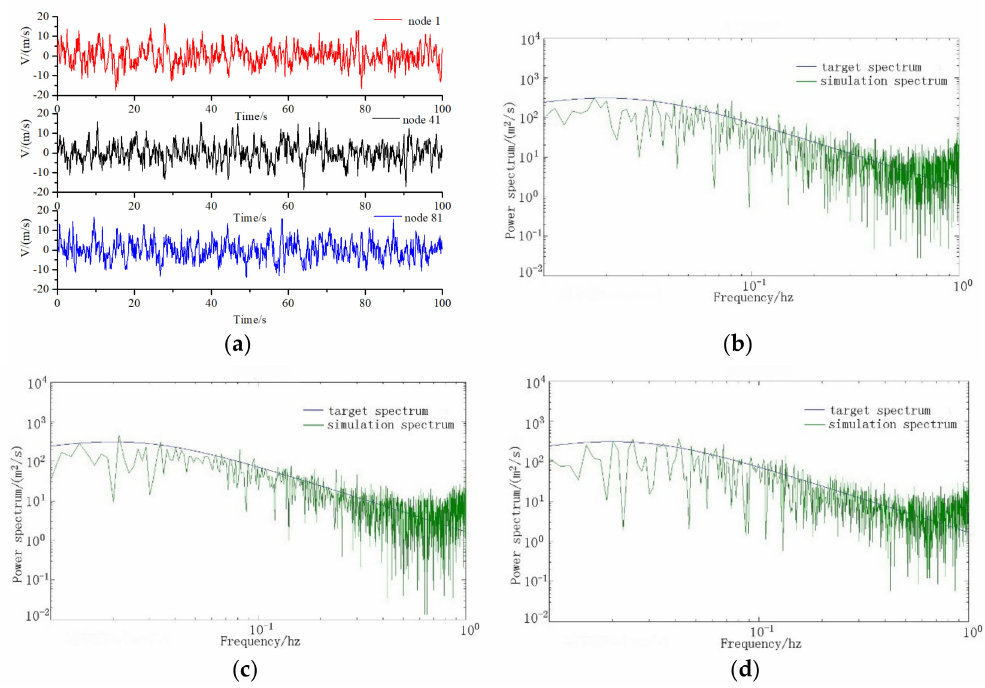
Figure 6. Wind speed time history and power spectrum density. ( a ) Wind speed time history curves of 1, 41, 81 nodes; ( b ) Power spectrum density function calibration of node 1; ( c ) Power spectrum density function calibration of node 41; ( d ) Power spectrum density function calibration of node